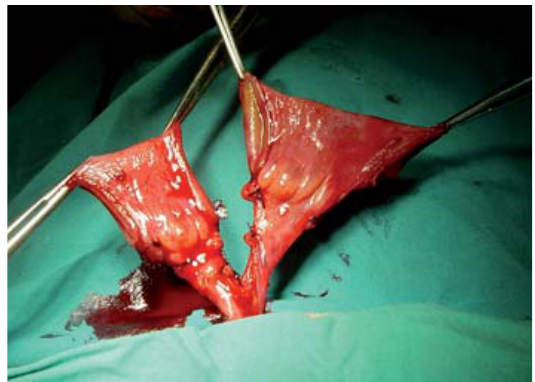
Figure 1 - Isolation of 2 ileal segments on their mesenteric pedicle.